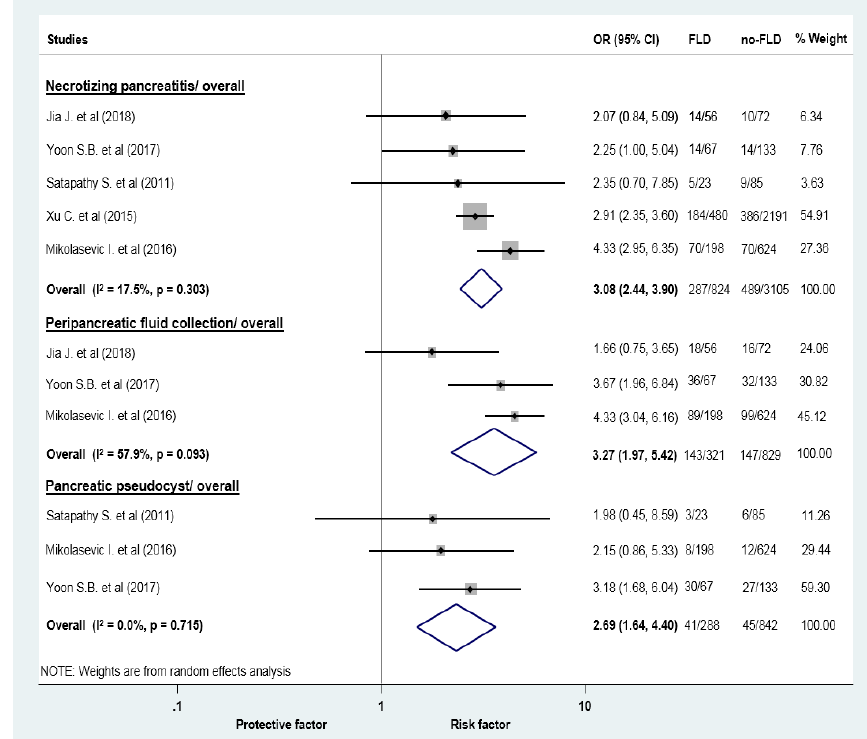
Figure 5. Forest plots of studies evaluating the association between fatty liver disease and the odds of local complications (necrotizing pancreatitis, peripancreatic fluid collection and pancreatic pseudocyst) in acute pancreatitis; CI: confidence interval, FLD: fatty liver disease, OR: odds ratio.